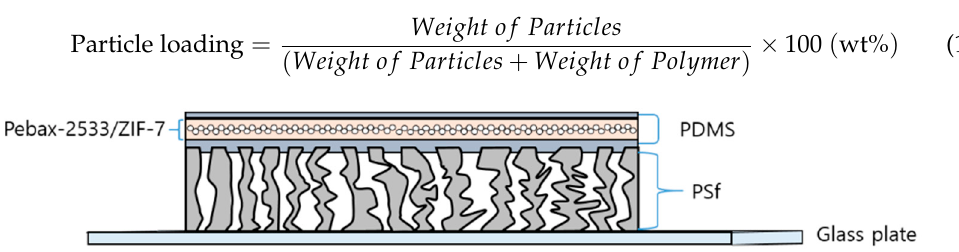
Figure 1. The fabrication of composite membrane.